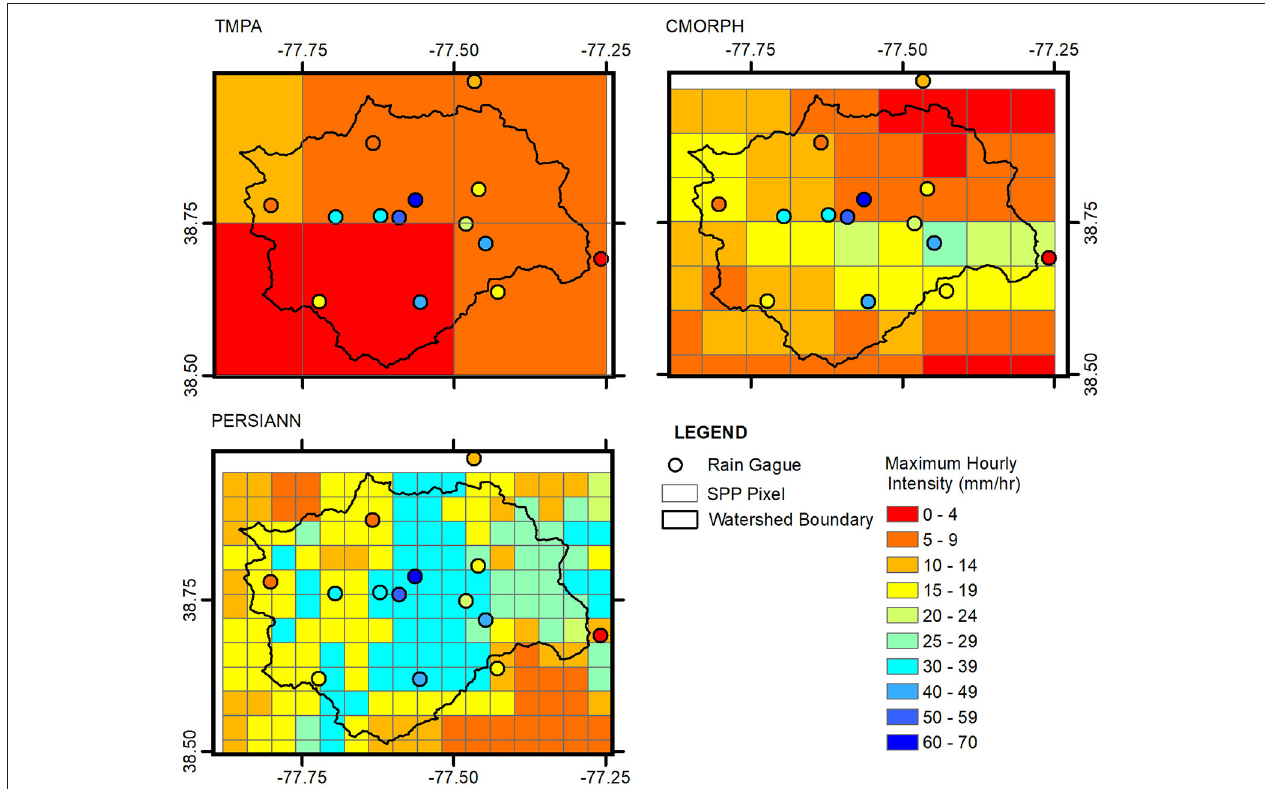
FIGURE 5 | Spatial maps of maximum hourly intensity (mm/h) across the watershed as recorded by rain gauges, TMPA, CMORPH, and PERSIANN for Event 4.